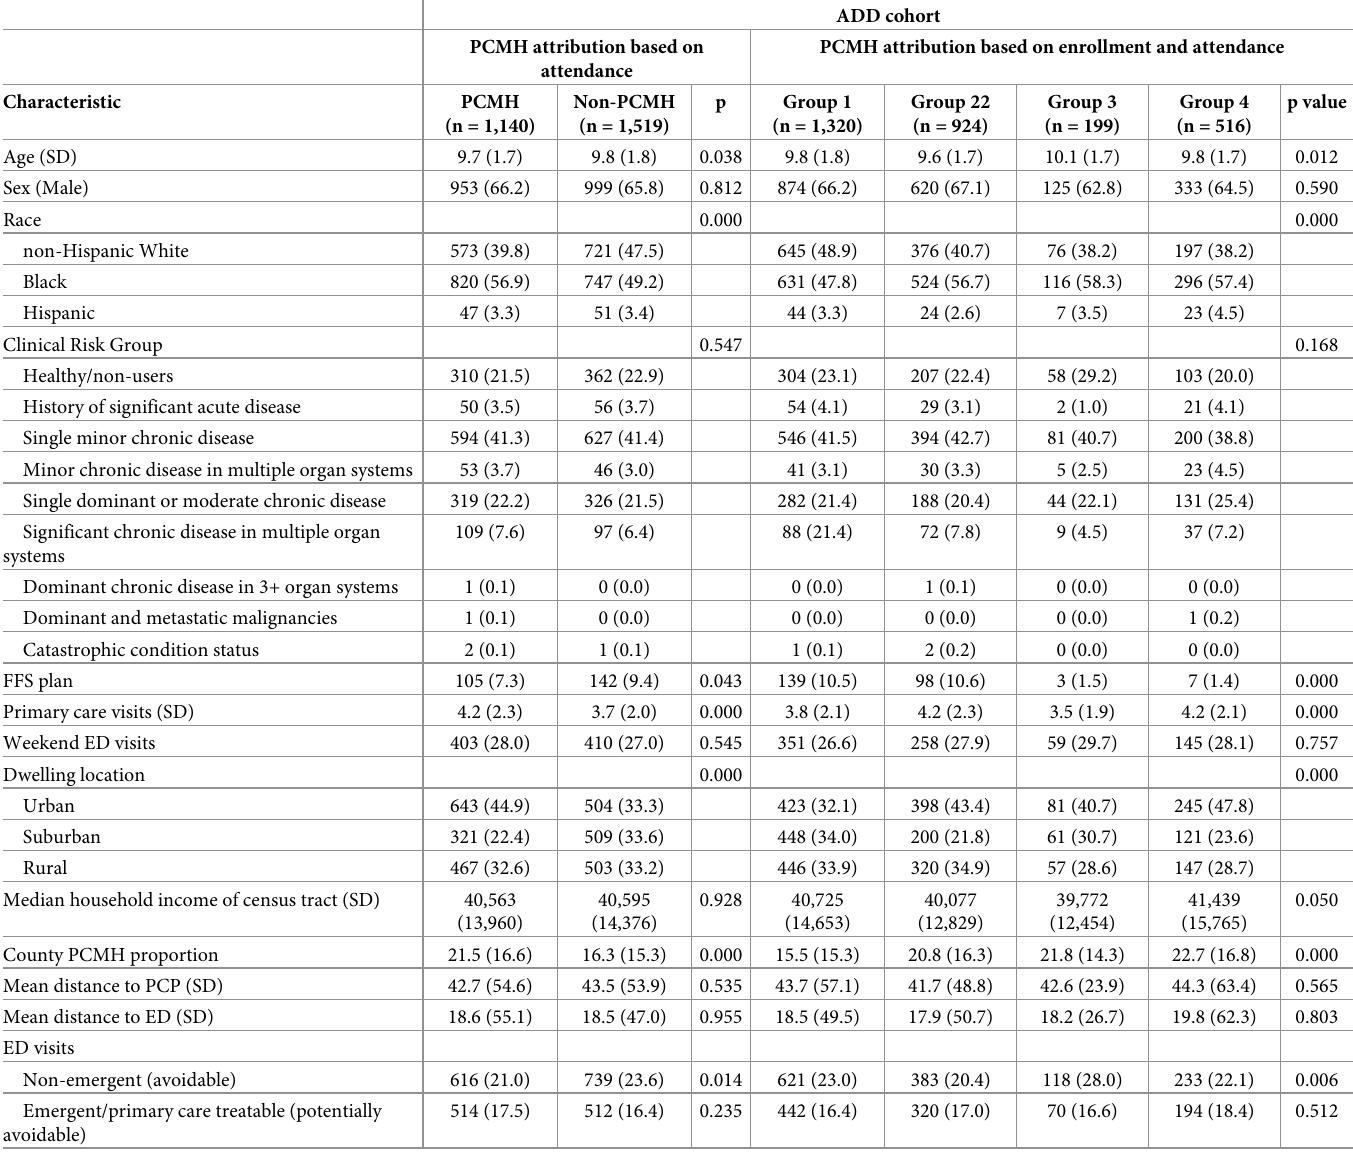
Table 1. Person-years summary statistics for ADD